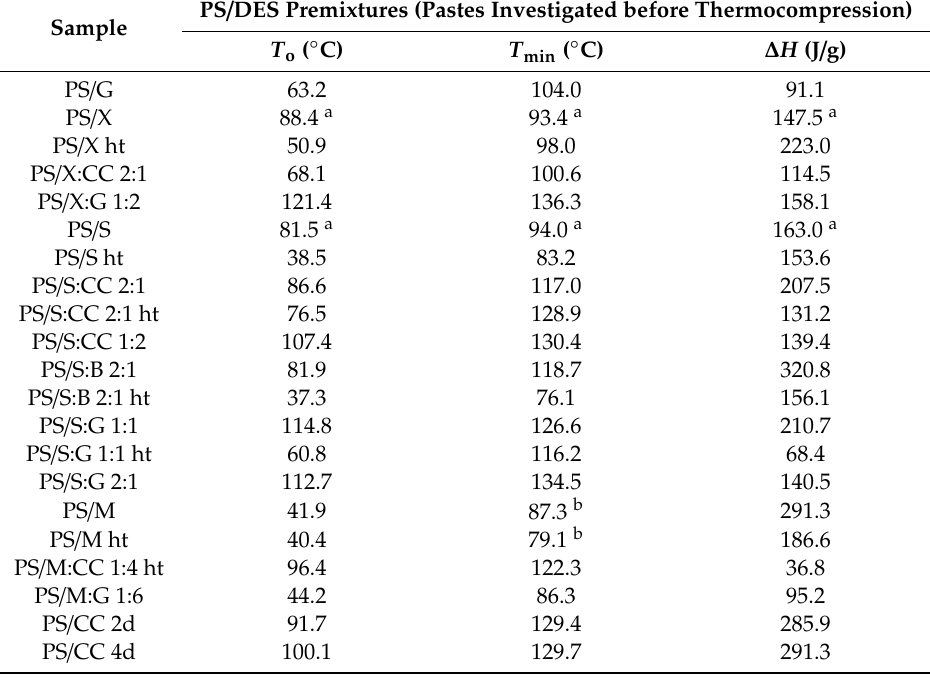
Table 3. DSC characteristics for potato starch (PS) / DES premixtures after 24 h of storage. Sample